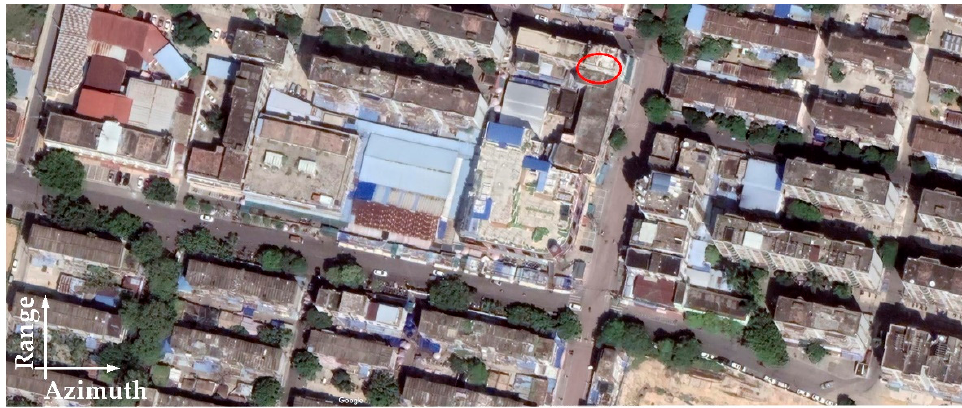
Figure 12. Panorama of the observed